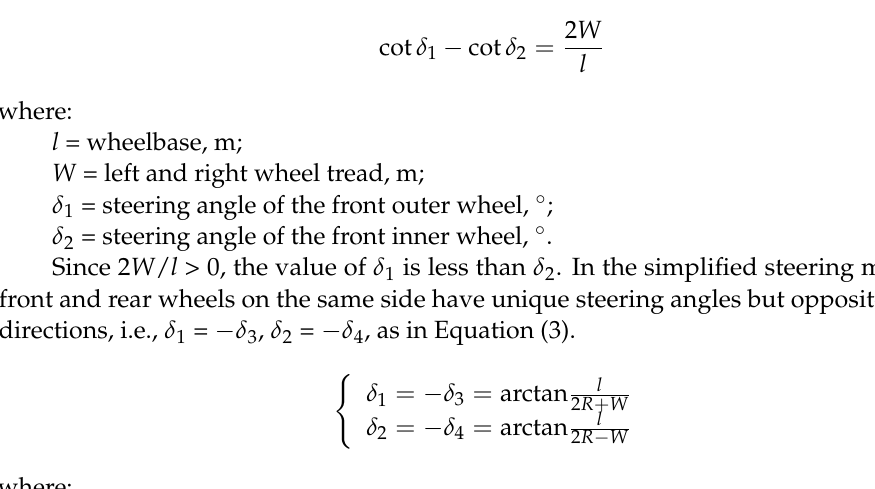
Figure 5. Kinematics model of the vehicle.